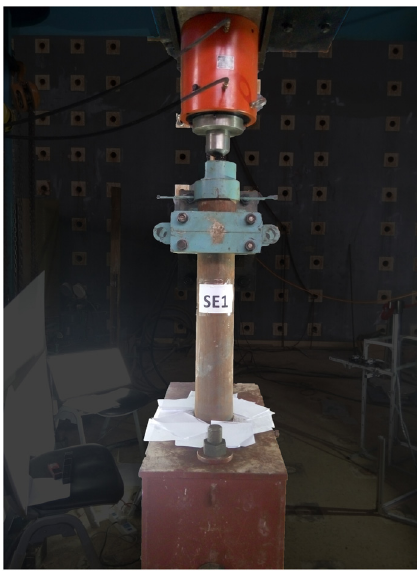
Figure 2: Loading diagram of test site of specimen assembly ( unit: mm ) .